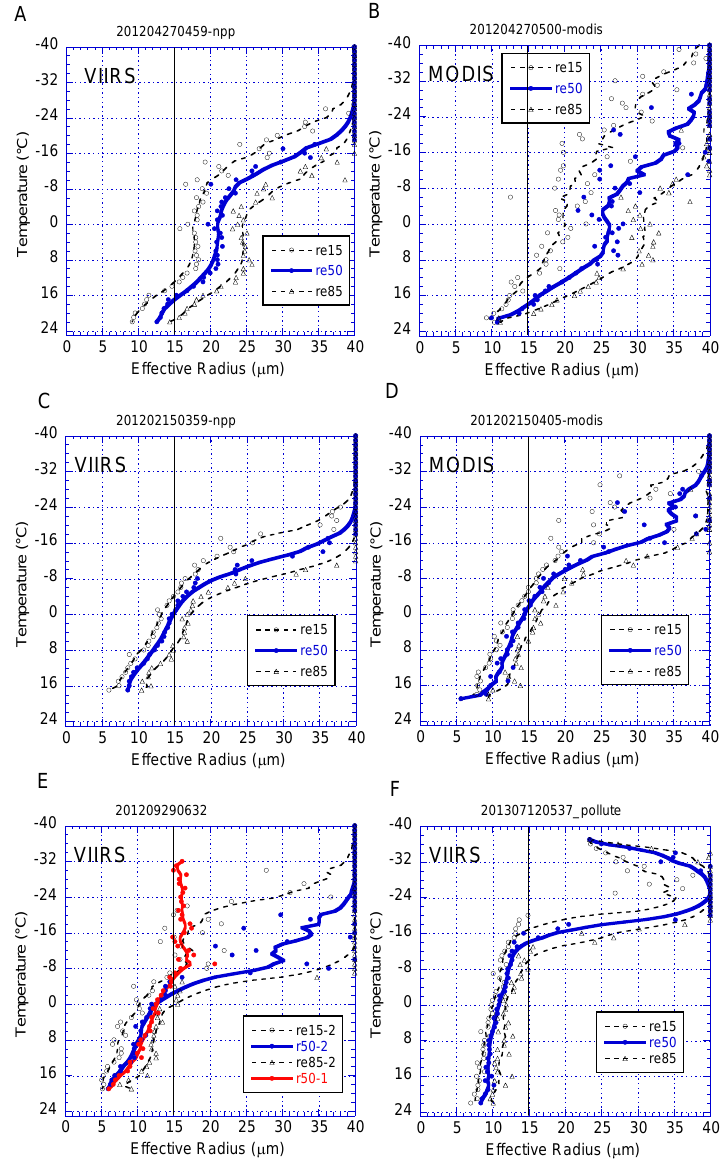
Fig. 22. The T – r e relations for deep tropical convective clouds under various aerosol conditions. Shown are the 15th percentile, the median, and 85th percentiles of the r e for any given T . Panels (A) and (B) : for marine pristine marine clouds as measured by VIIRS and MODIS, respectively, shown in Fig. 18. Note the flattening of r e at ∼ 22µm between 8 and − 7 ◦ C, which is indicative of the rainout zone; (B) and (C) : pristine continental clouds over SE Australia for VIIRS and MODIS, respectively, shown in Fig. 19; (E) : growing (line 1) and maturing (line 2) convective elements in smoky air in west Java, shown in Fig. 20; (F) : growing convective clouds in haze of industrial pollution in SE China, shown in Fig.